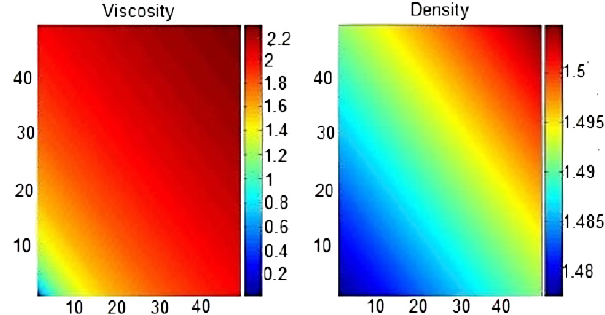
Figure 1. Distribution of viscosity η and density ρ ; 2-D case, lin- early varying viscosity, high-viscosity contrast ( η 2 = η 3 = 100).